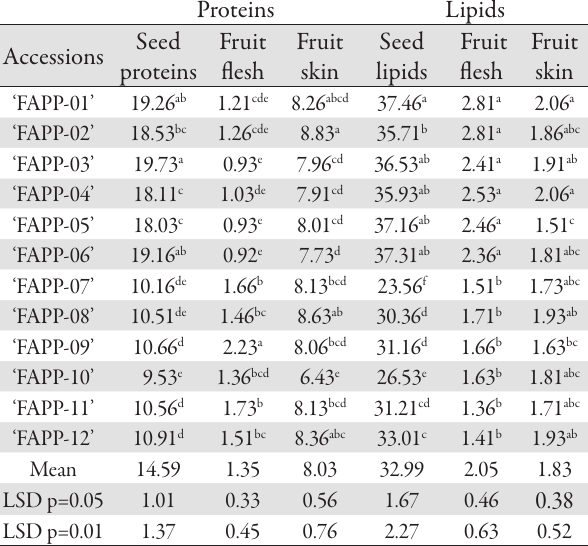
Tab. 3. Parameters for protein and lipid content at pumpkin